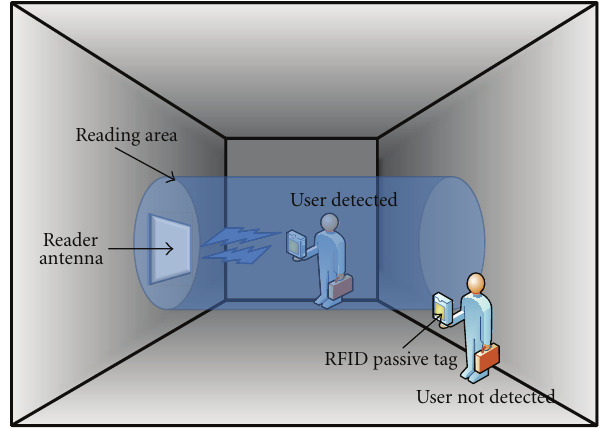
Figure 8: RFID System working with proximity